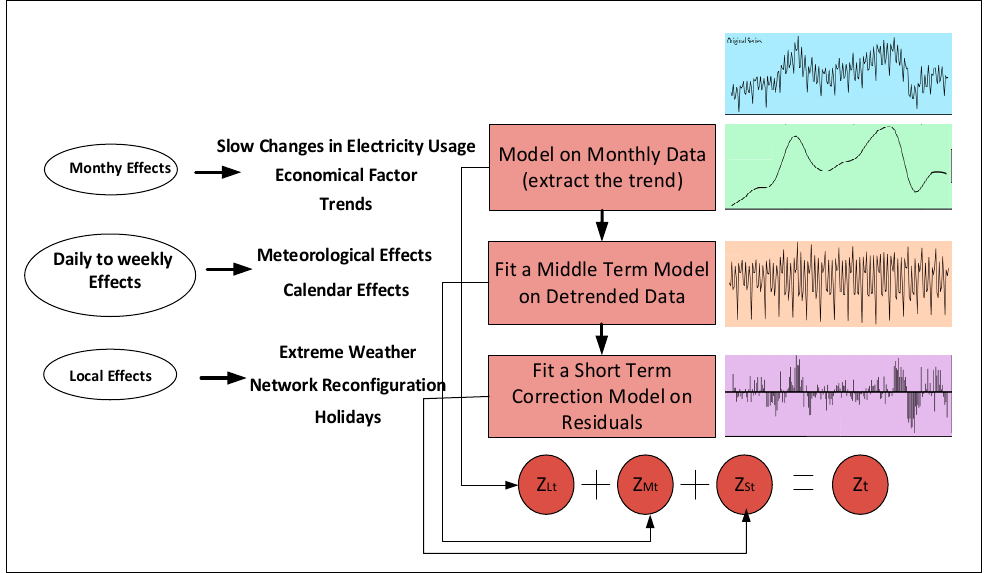
Figure 6. Stepwise algorithm for STLF [48].